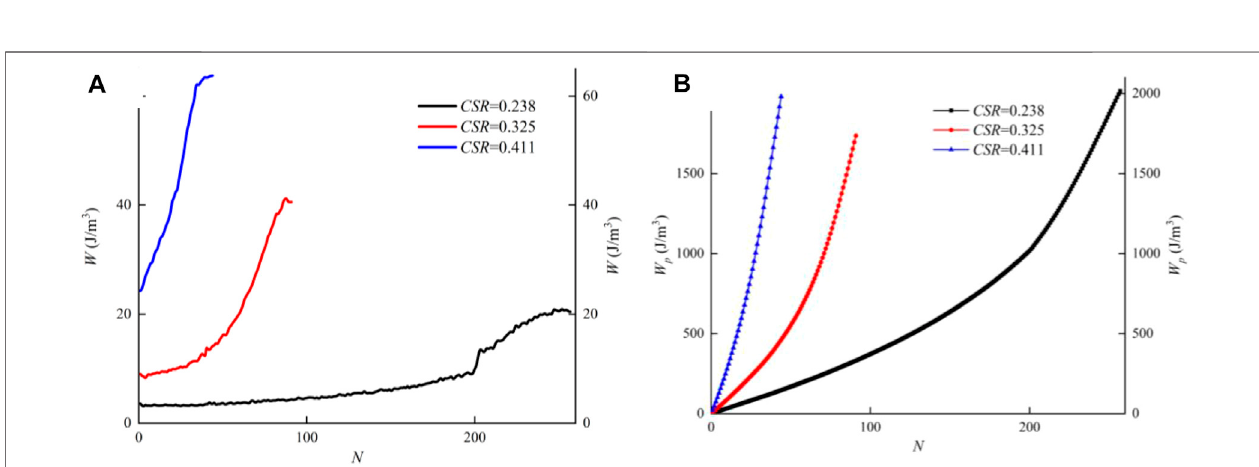
FIGURE 8 | Evolution characteristics of dissipated energy under different frequencies: (A) dissipated energy per cycle and (B) cumulative dissipated energy.